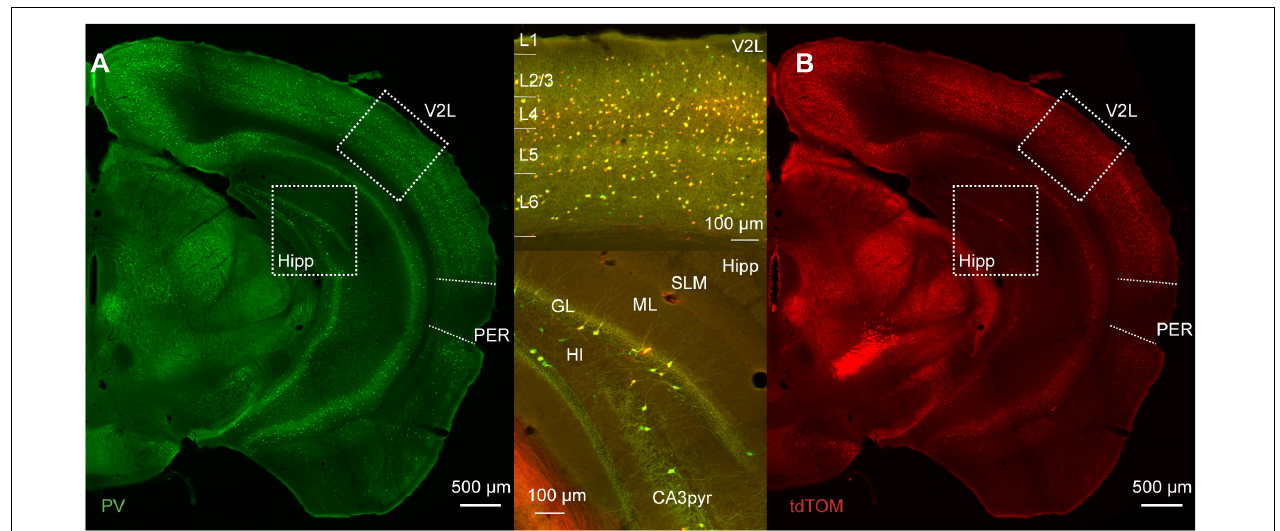
FIGURE 1 | (A) Representative immunofluorescence staining for PV of a slice at about bregma − 3 mm of a PVcre/Ai9 mouse. Dotted boxes highlight the lateral part of the secondary visual cortex (V2L) and the hippocampus (Hipp). The perirhinal cortex (PER) is delineated by the dotted line on the lateral side of the brain. (B) Representative image of the immunofluorescence for tdTomato in the same section as (A) . Upper insert shows the merged signals in the cortex, and lower insert shows merged signals in the hippocampus (SLM, stratum lacunosum-moleculare; ML, molecular layer; GL, granule layer of the dentate gyrus; Hl, hilus; CA3pyr, pyramidal layer of the CA3